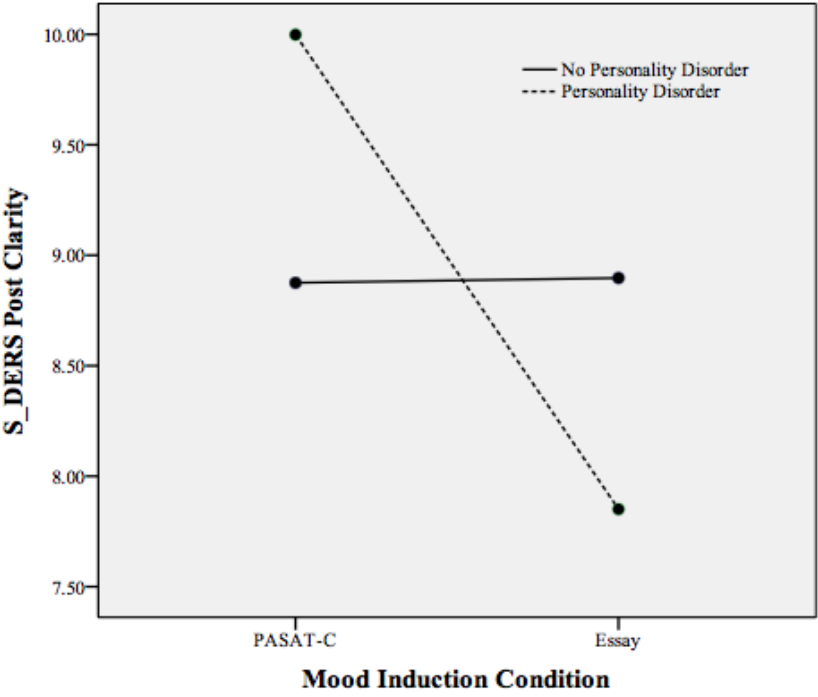
Figure 4 . Plot of the statistically significant interaction between mood induction condition and personality disorder on the S-DERS subscale of state difficulties in emotional clarity following both mood inductions. Higher scores indicate more difficulties in emotional